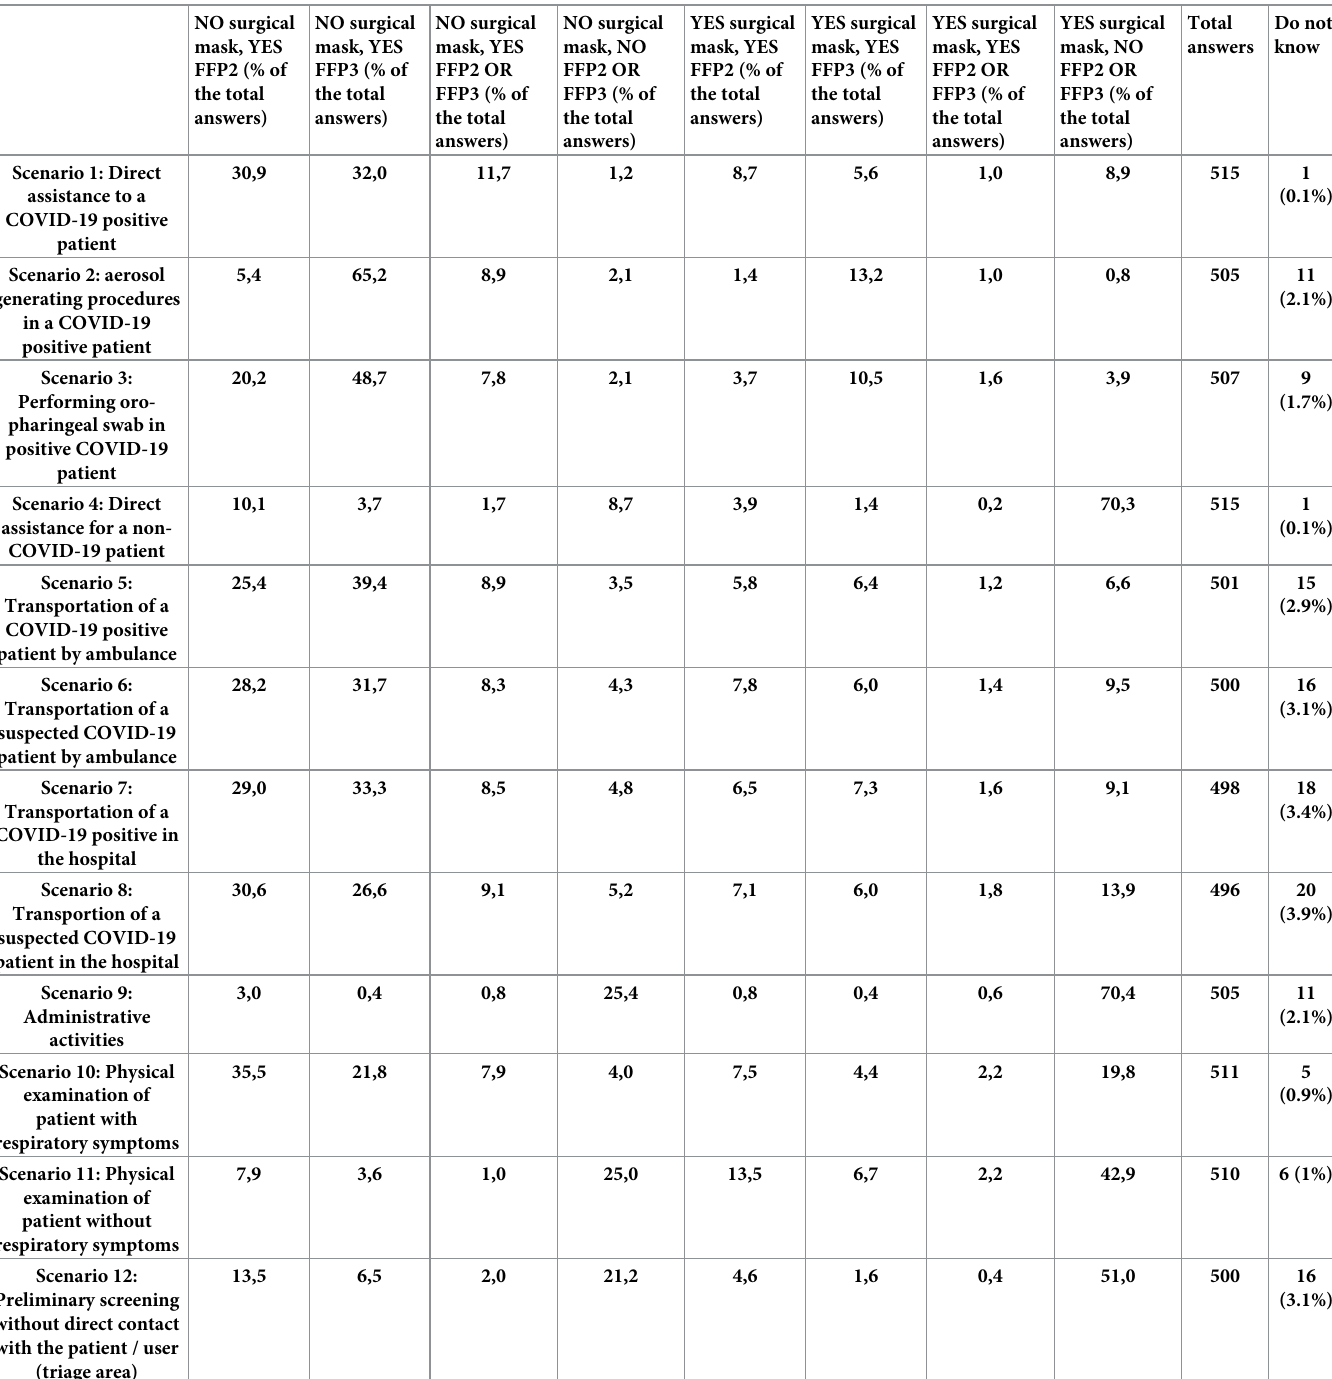
Table 3. Percent of physicians reporting level of PPE needed compared to recommendations at the time of survey for twelve